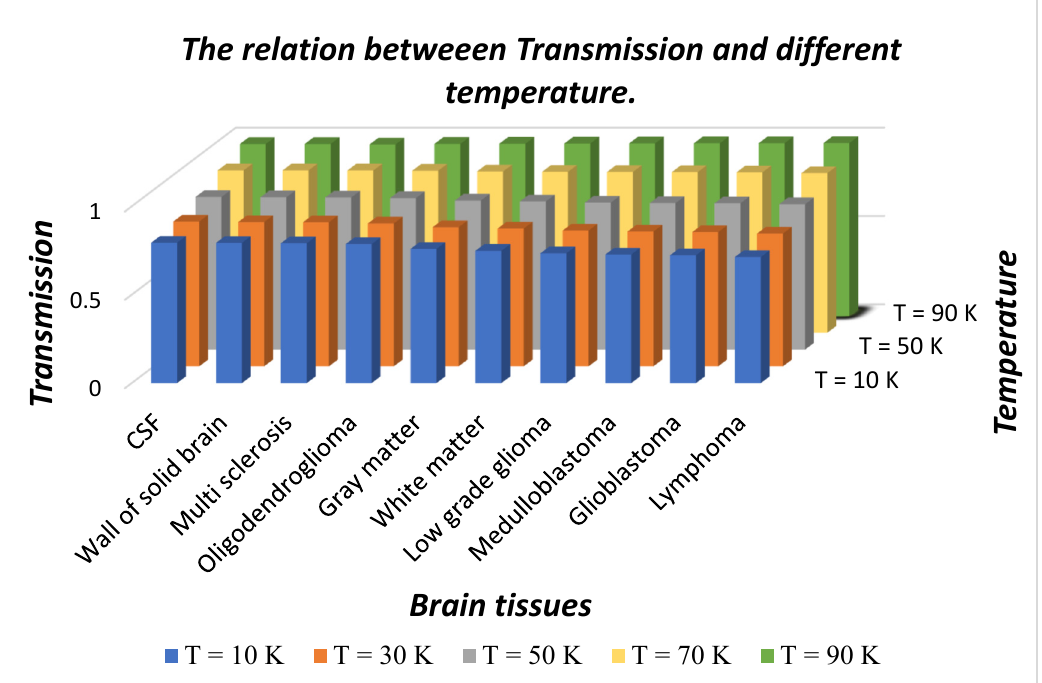
Figure 7. The 3D bar graph showing temperature dependent transmittance of defect mode originates due to presence of different samples inside cavity one by one at d 4 = 15 dd , η = 0.8 and θ = 63 °. The ambient temperature varies between 10 K to 90 K.